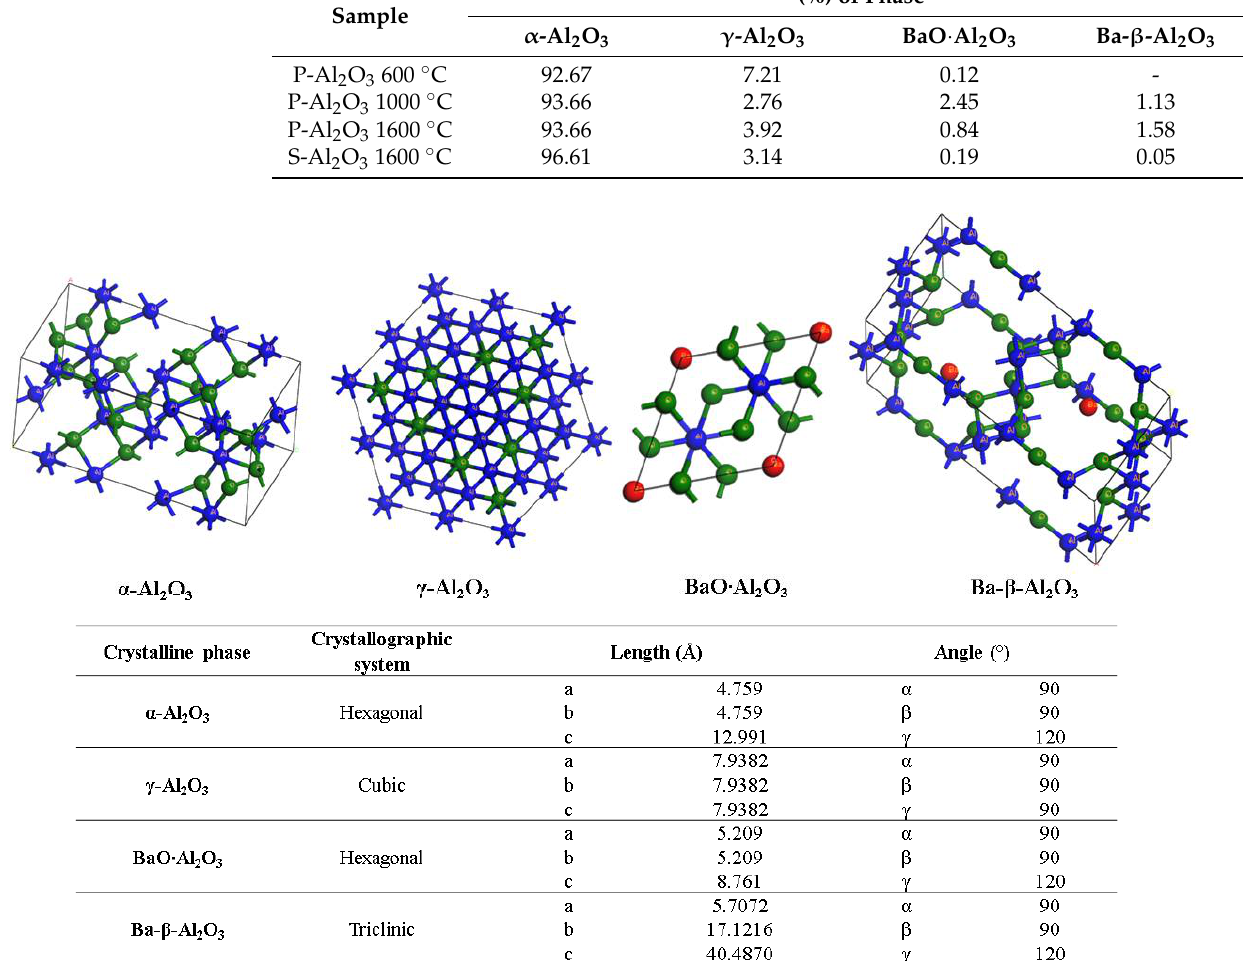
Figure 7. Crystalline systems and network parameters of the analyzed